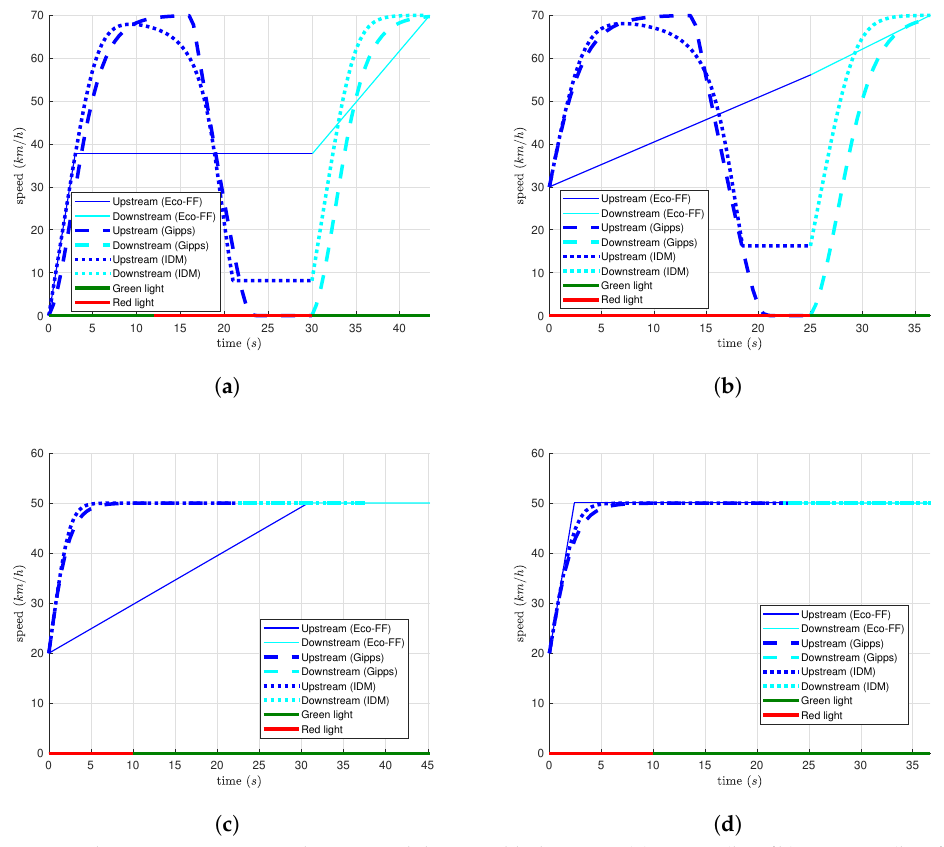
Figure 3. The eco-FF, Gipps, and IDM models’ speed behaviors. ( a ) v i = 0 (km/h), v d = 70 (km/h), and c 4 = 970 (W). ( b ) v i = 30 (km/h), v d = 70 (km/h), and c 4 = 970 (W). ( c ) v i = 20 (km/h), v d = 50 (km/h), and c 4 = 970 (W). ( d ) v i = 20 (km/h), v d = 50 (km/h), and c 4 = 2550